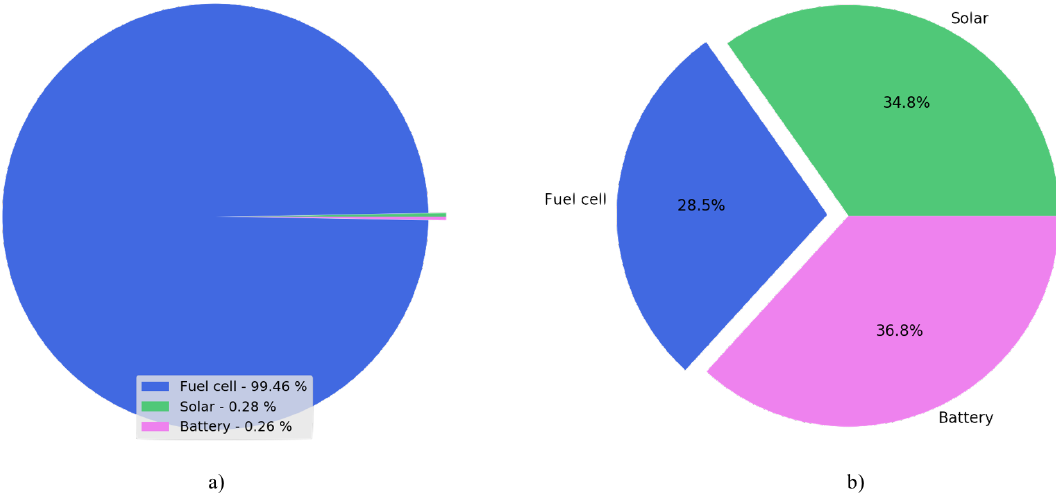
Figure 5. Example of energy usage by power sources for low consumer with priority-based internal agent ( a ) without fuel cell scheduling function and ( b ) with added scheduling capabilities.